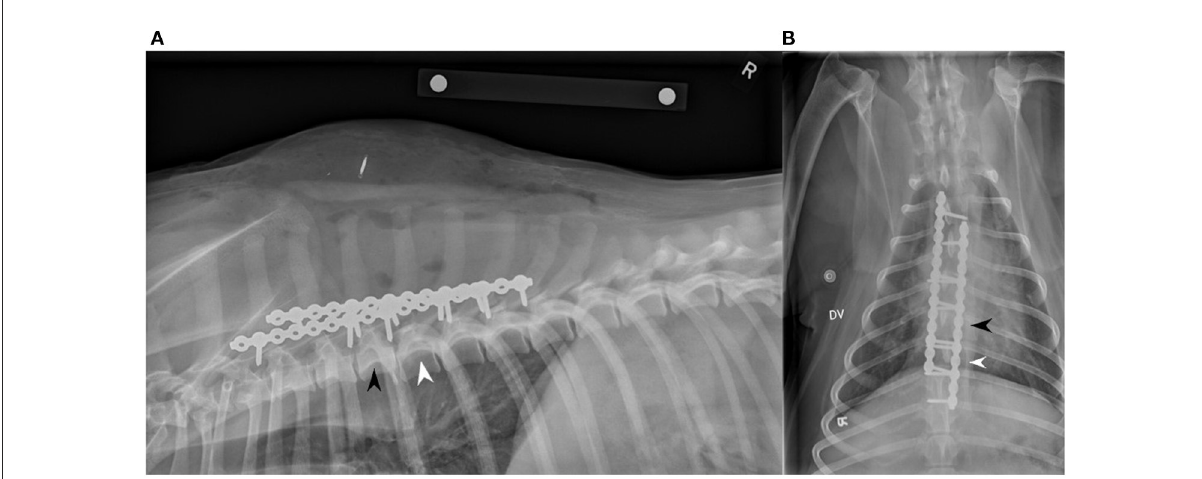
FIGURE3 Right lateral (A) and dorsoventral (B) two view post-operative radiographs showing two SOP ® dorsal locking plates successfully implanted. A 14-hole SOP ® locking plate was used on the left side with six 2.7mm screws placed into the bases of the dorsal spinous processes/laminae of T3, T4, T5, T6, T7, and T8. A second 14-hole SOP ® locking plate was used on the right side with five 2.7mm screws placed into the bases of the dorsal spinous processes/laminae of T2, T4, T5, T6, and T7. The black arrowhead indicates T5, and the white arrowhead indicates